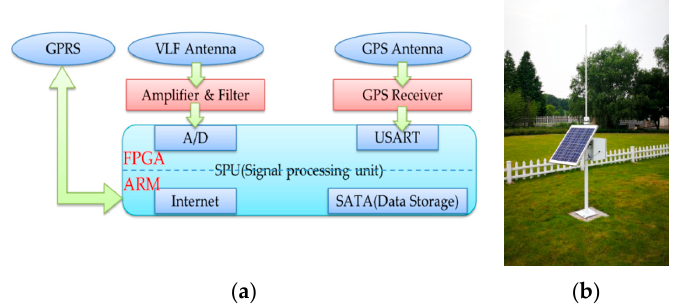
Figure 2. ( a ) Block diagram of the VLF lightning sensor. ( b ) Photo of a VLF lightning detection site in Hangzhou, China.